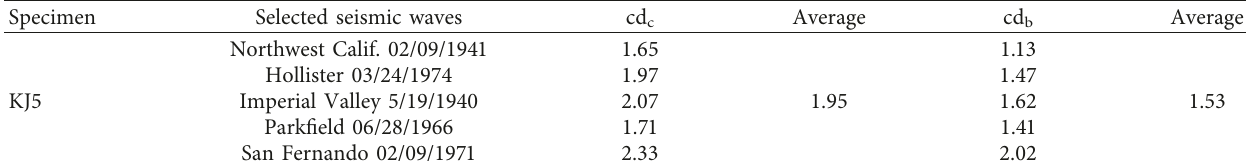
Table 16: Maximum curvature ductility coefficients of beams and columns in model KJ5. Specimen